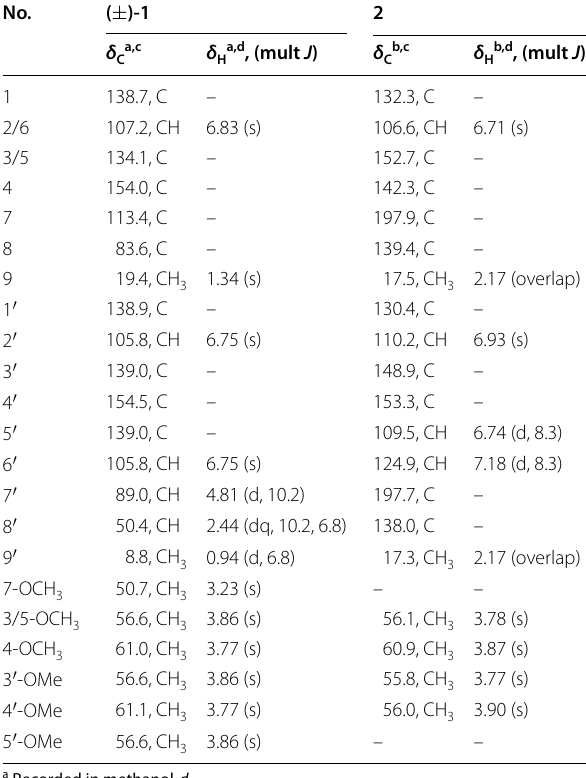
Table 1 1 H and 13 C NMR spectroscopic data for compounds 1 and 2 ( δ in ppm, J in